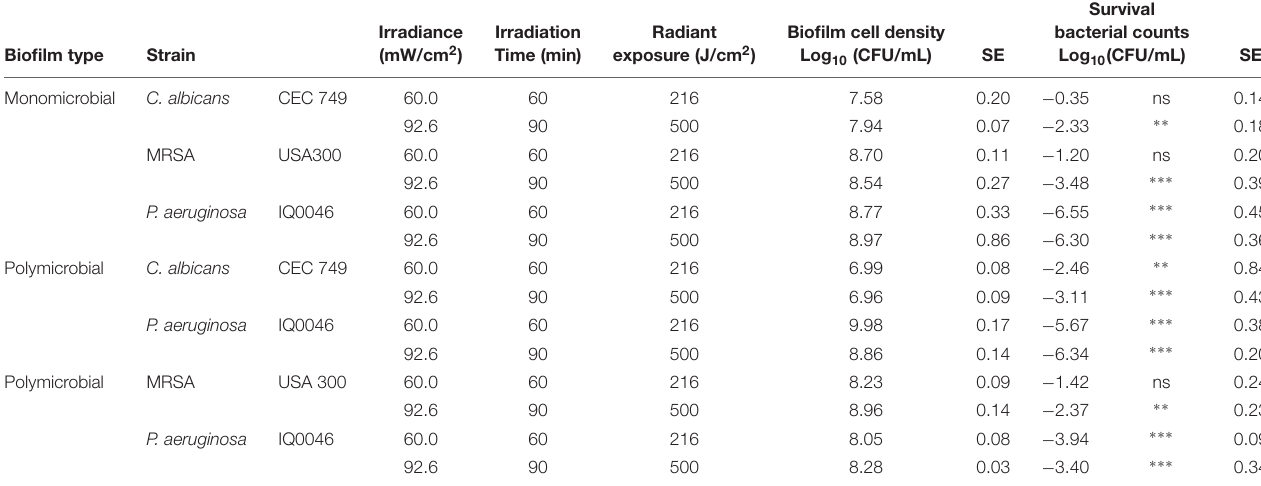
TABLE 1 | Effectiveness of antimicrobial blue light (405 nm) inactivation of biofilms grown in 96-well microtiter plates after 24 h of